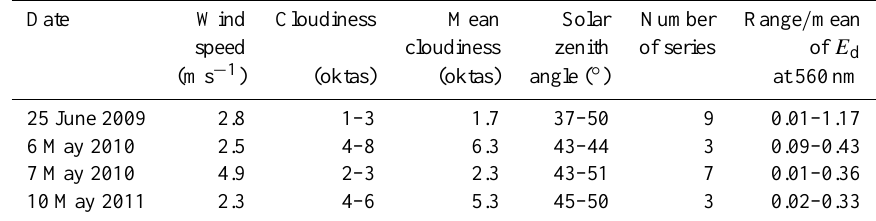
Table 1. Environmental conditions during field work at 59 ◦ 49 (cid:48) N, 10 ◦ 34 (cid:48)